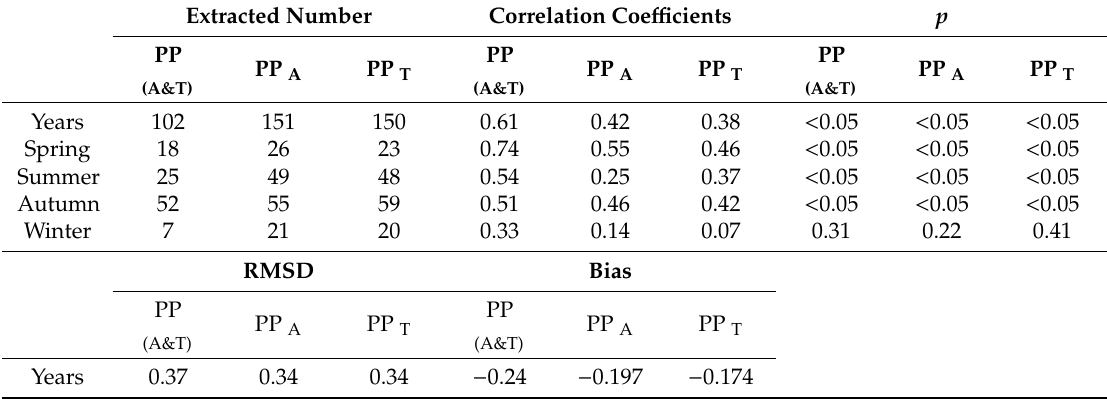
Figure 3. Spatial distribution of in situ PP determined using light–dark bottle methods in 2011: ( a ) winter, ( b ) spring, ( c ) summer, and ( d ) autumn. Table 2. Extracted number of satellite-derived PPs with in situ PPs, correlation coefficients (r 2 ), and p values for PP A&T , PP A, and PP T for whole years and different seasons. The RMSD and bias for PP A&T , PP A, and PP T for whole years.